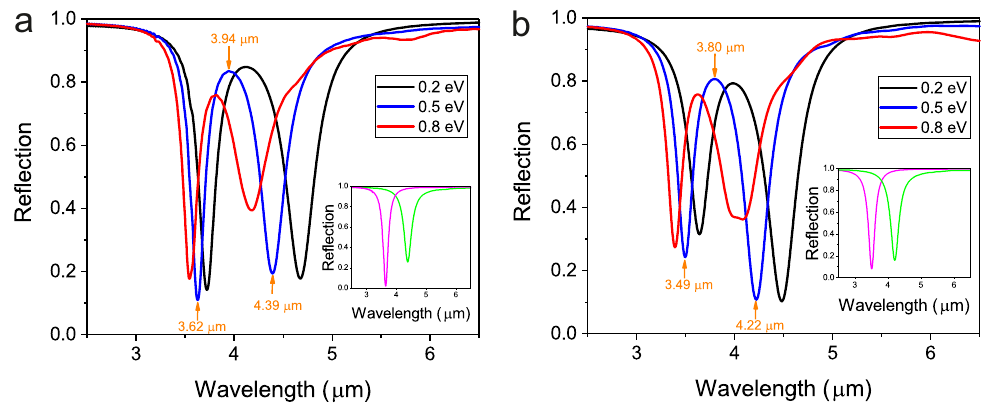
Figure 2. Simulated reflection results of ( a ) the first device and ( b ) the second device at 0.2, 0.5, and 0.8 eV . The insets show the reflection spectra of the bright modes excited individually: ( a ) shorter rectangular antenna (pink), longer antenna (green), and ( b ) rectangular antennas (pink) and disk (green).